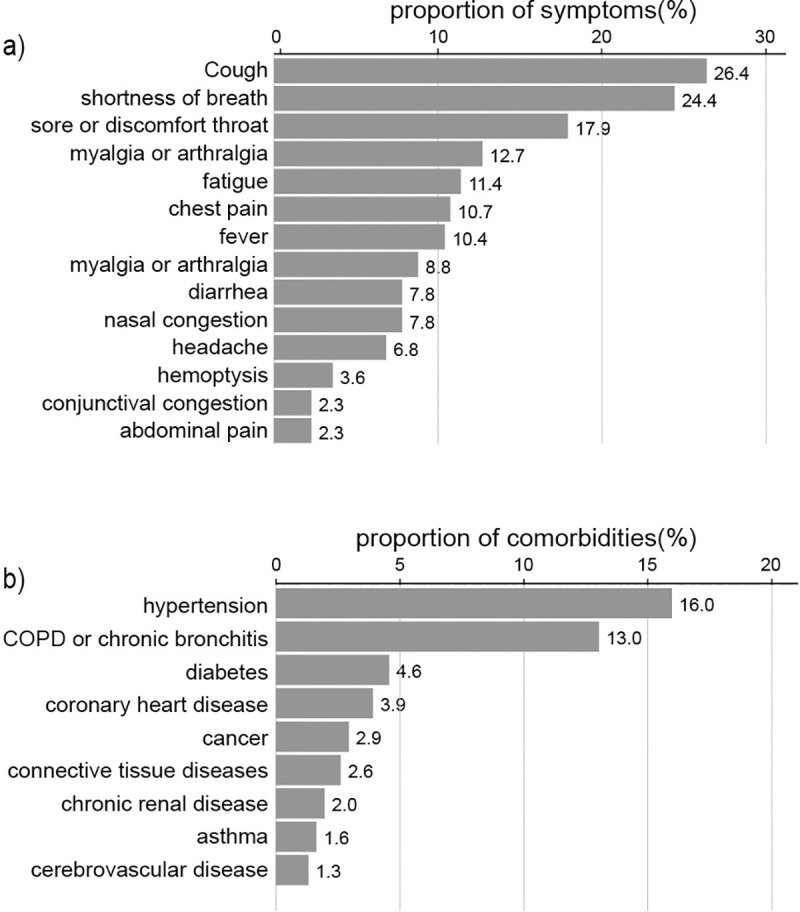
Histogram of the frequency distribution of comorbidities and current physical symptoms.a: Histogram of the frequency distribution of comorbidities of patients in Jianghan Fangcang Shelter Hospital in Wuhan, China. b: Histogram of the frequency distribution of current physical symptoms of patients in Jianghan Fangcang Shelter Hospital in Wuhan, China. COPD: Chronic obstructive pulmonary disease.